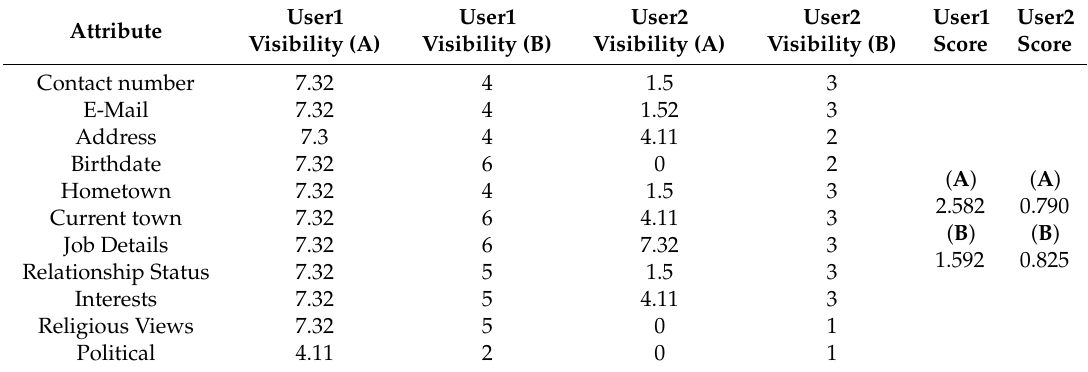
Table 6. Visibility and privacy